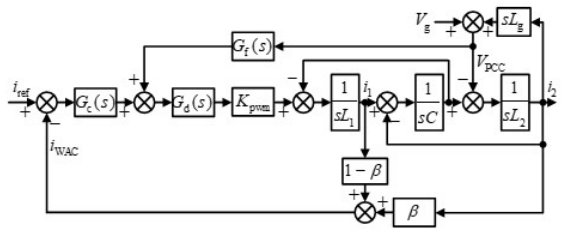
Fig. 2. WAC control system structure diagram of grid-connected inverter.